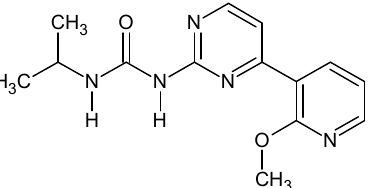
Figure 7. The structure of 1-[4-(2-methoxypyridin-3-yl)pyrimidin-2-yl]-3-propan-2-yl urea. Ureido-N-iso-propyl,N’-4-(3-pyridin-2-on)pyrimidine (Figure 8) [52]. To the solution of 0.25 g of 1-[4-(2-methoxypyridin-3-yl)pyrimidin-2-yl]-3-propan-2-yl urea in anhydrous DCM (5 mL) at − 20